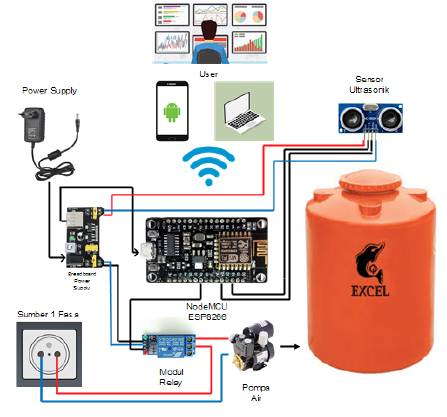
Figure 1. Tool Schematic